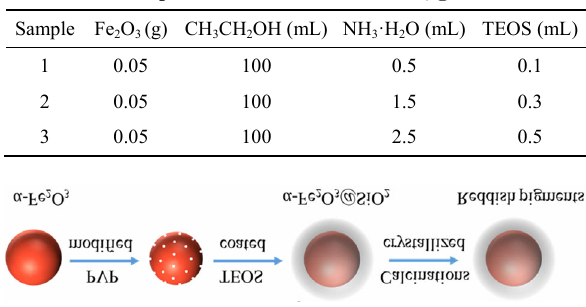
Formation scheme for α-Fe 2 O 3 @SiO 2 reddish